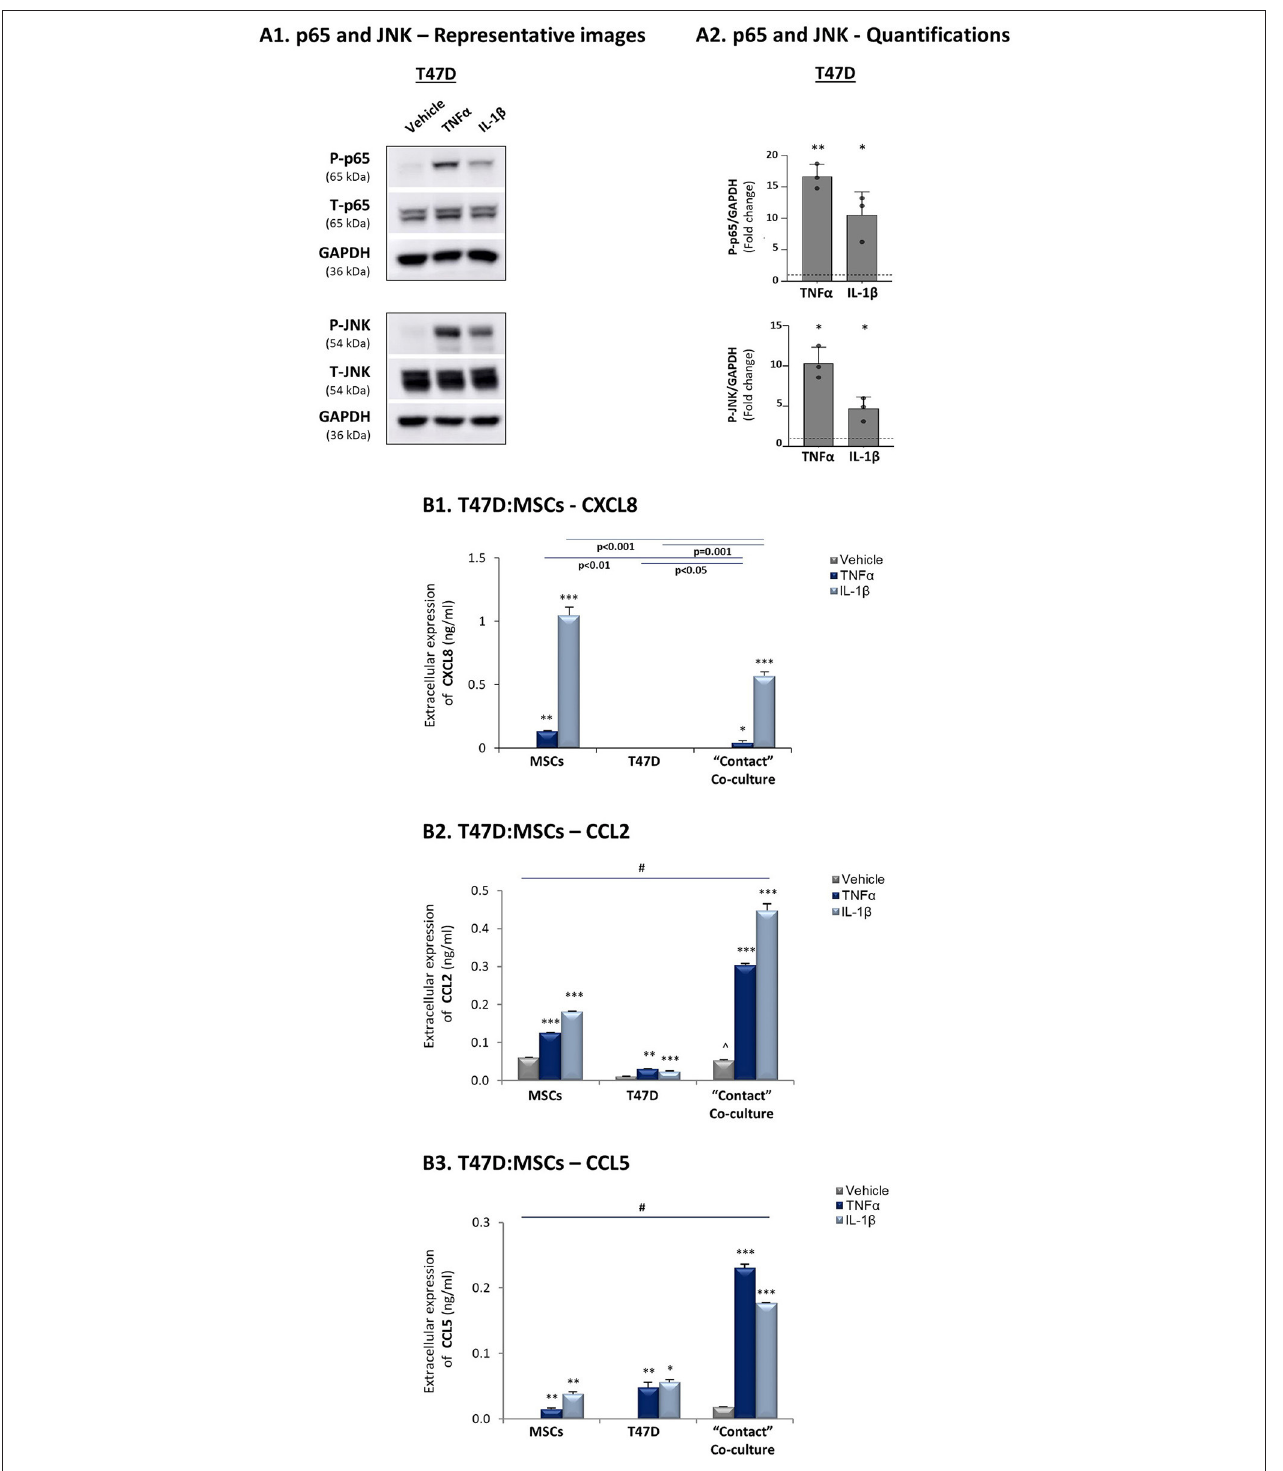
FIGURE 6 | CXCL8 expression is down-regulated in TNF α - and IL-1 β -stimulated luminal-A (T47D): MSC “Contact” co-cultures. The Figure demonstrates similar experiments and statistical analyses as those of Figure 3 , performed herein with T47D cells and MSCs. Cytokine concentrations: 50ng/ml TNF α and 500 pg/ml IL-1 β . (A) Activation of p65 and JNK. (B) CXCL8 (B1) , CCL2 (B2) and CCL5 (B3) expression levels. ∧ In panel B2, comparisons to non-stimulated MSCs were non-reproducible. In all parts of the Figure, the results are of a representative experiment of n = 3 independent experiments, performed with MSCs of ≥ 2 different donors. *,**,***, # - As described in Figure 3